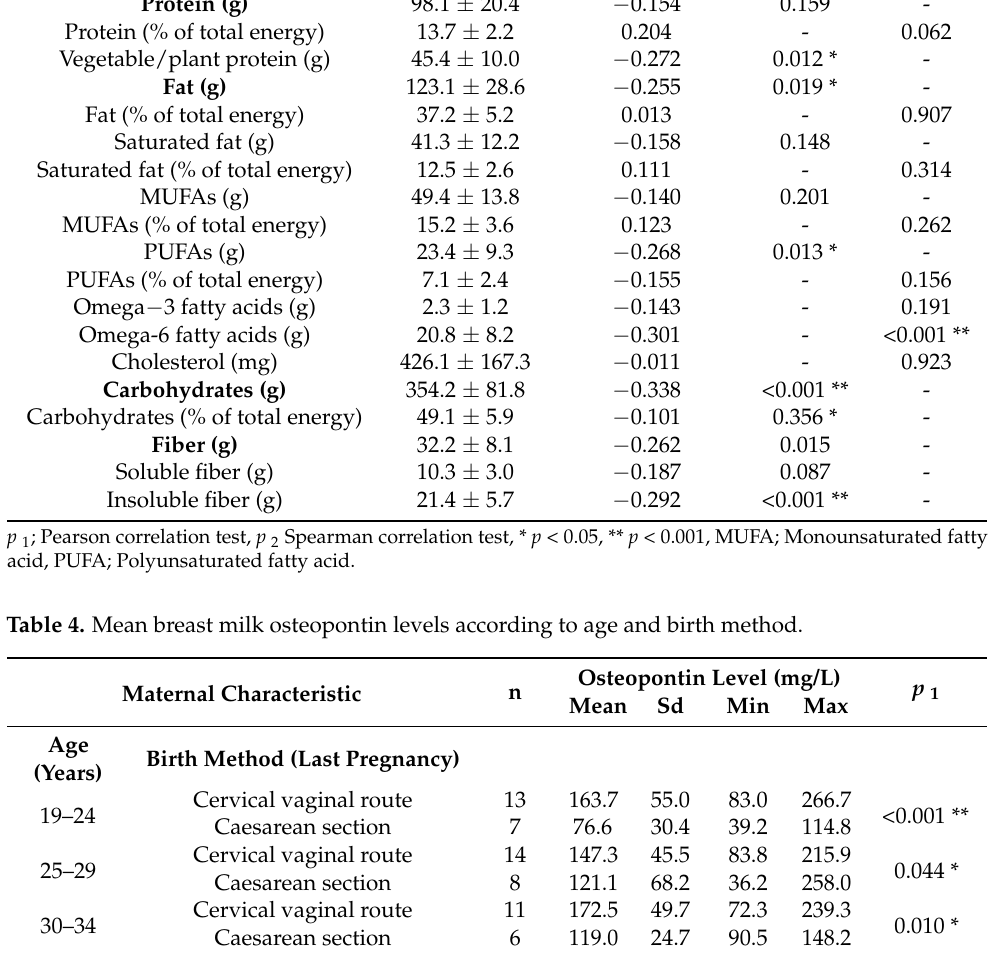
Table 3. Maternal energy and macronutrient intake in lactation period (0–3 months) and their correlation with breast milk OPN (Osteopontin) levels at month 3 study visit.